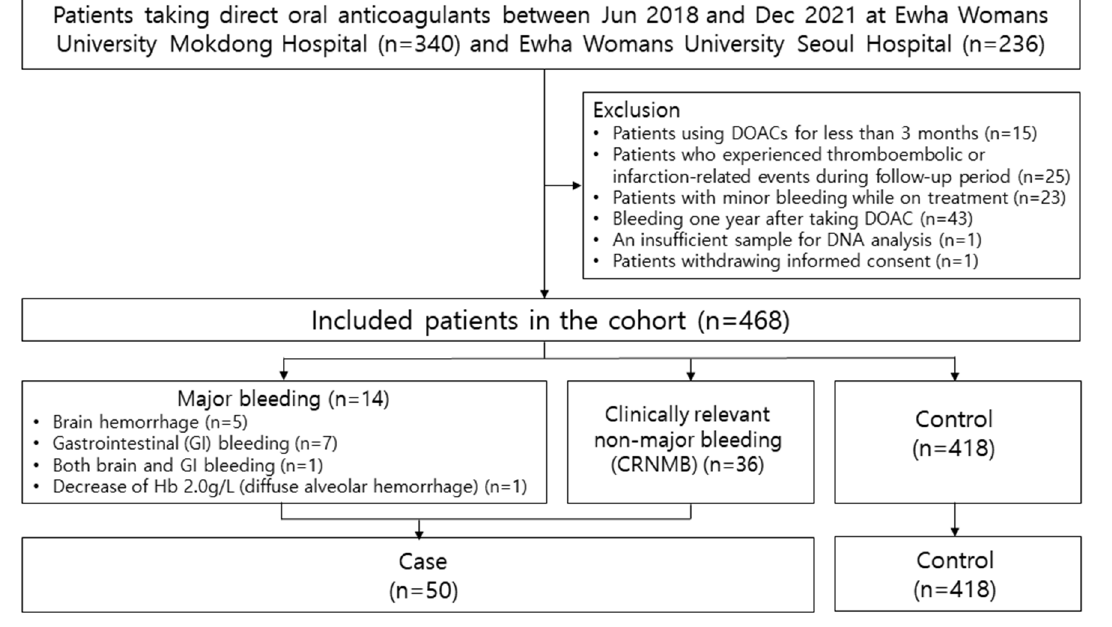
Figure 1. Patient Figure 1. Patient flowchart.